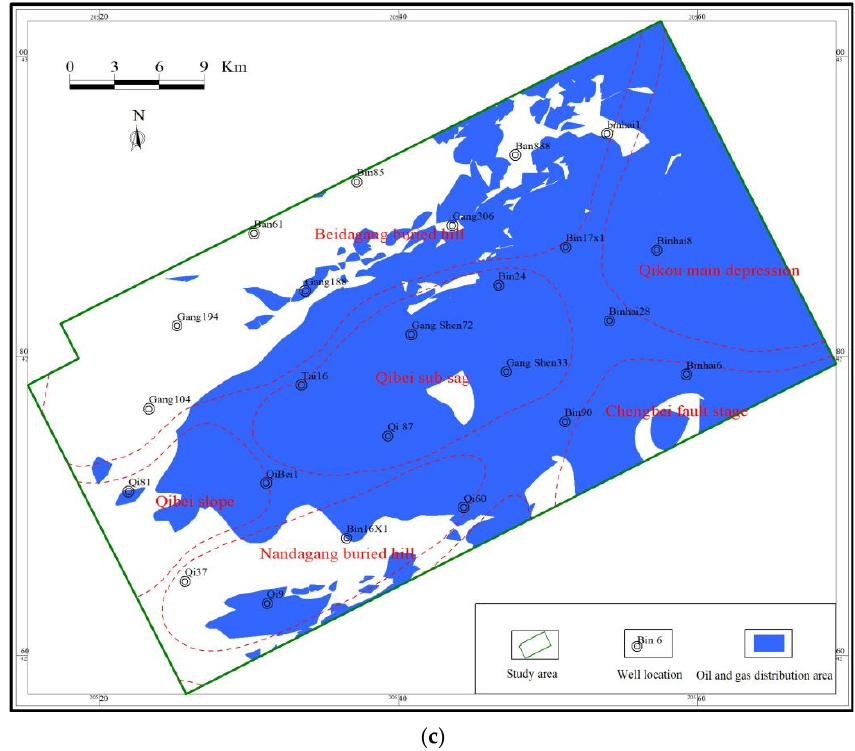
Figure 5. Oil and gas distribution in the lower section of the Ed-3 Member in the south of the northern Dagang area. ( a ) Hydrocarbon reservoirs outside source rocks in the lower section of the Ed-3 Member. ( b ) Hydrocarbon reservoirs within source rocks in the lower section of the Ed-3 Member. ( c ) Oil and gas distribution at the lower section of the Ed-3 Member.